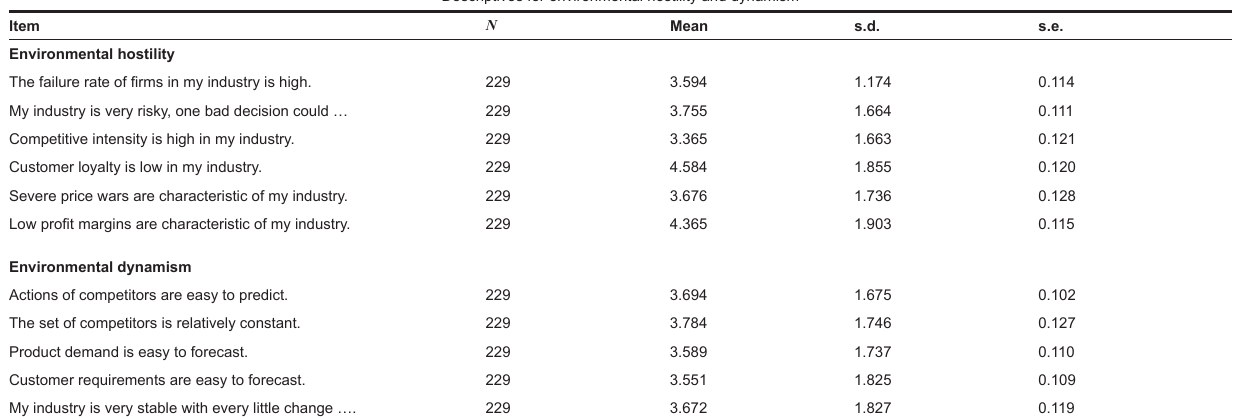
TABLE 7 Descriptives for environmental hostility and dynamism